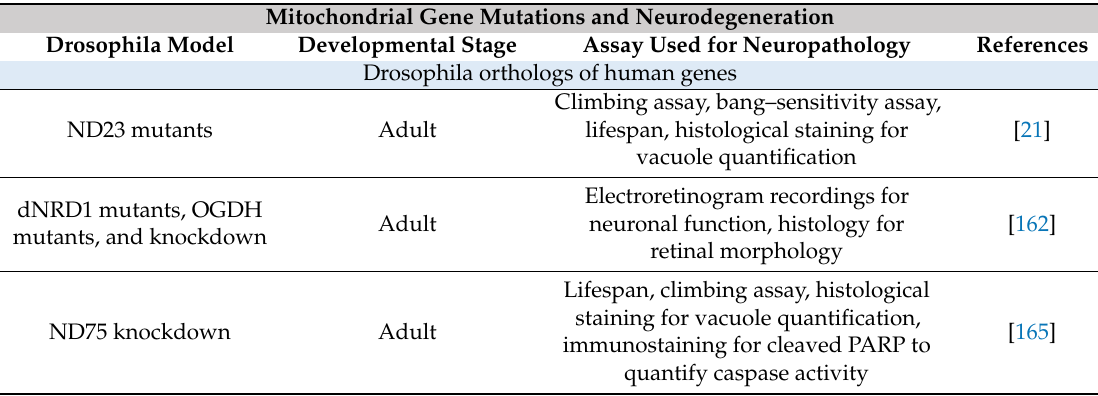
Table 6. Drosophila models of neurodegenerative mitochondrial gene mutations.